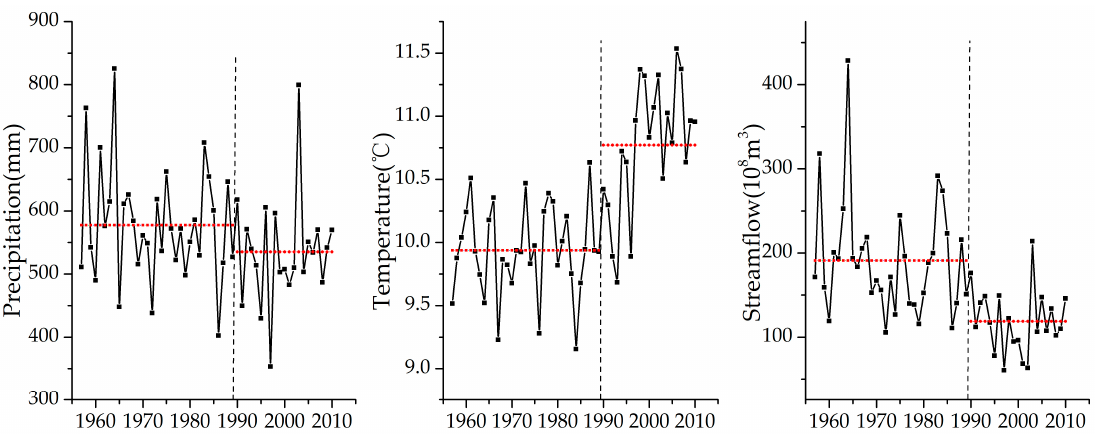
Figure 4. Long-term variations in annual precipitation (P), temperature (T), and streamflow (R) in the Long-Hua region in YRB.